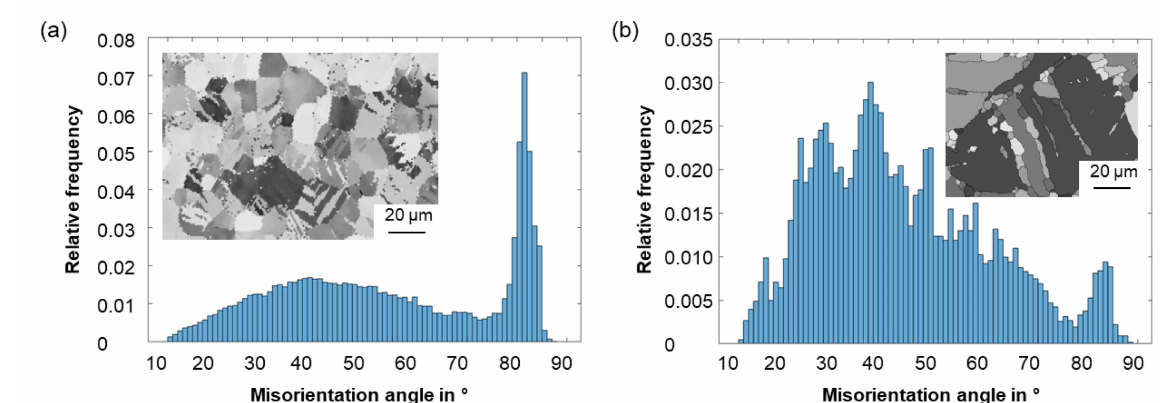
Figure 5. Misorientation angle distribution and electron backscatter diffraction (EBSD) map of the measured area after deformation at 350 ◦ C under a strain rate of 10 s − 1 ( a ) at ϕ = 0.2 and ( b ) ϕ = 0.6 (selected areas with